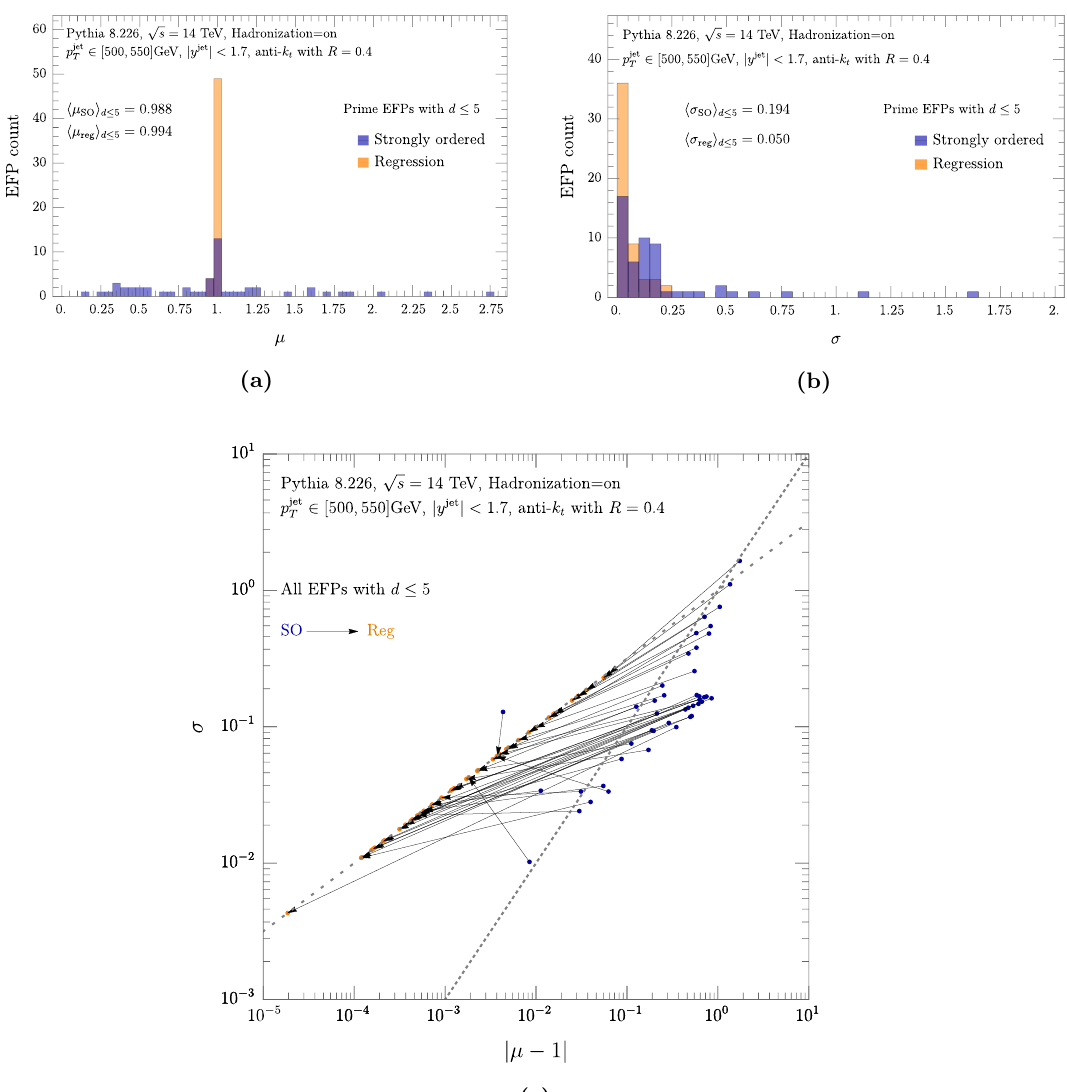
Figure 5. Histogram for the average µ (a) and standard deviation σ (b) of the ratio between prime EFPs up to degree 5 and their expression in terms of SO basis elements. Here, the relationship was found using power counting (blue) and regression (orange). The improvement from using regression is visualized with arrows in the scatter plot (c) for | µ − 1 | and σ . The dashed line corresponds to σ = | µ − 1 | , and the dotted line corresponds to σ 2 = | µ − 1 |